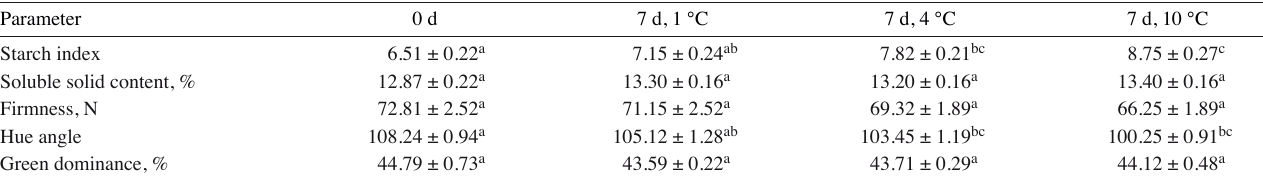
Different superscript letters in a row show significant difference at p<0.05.